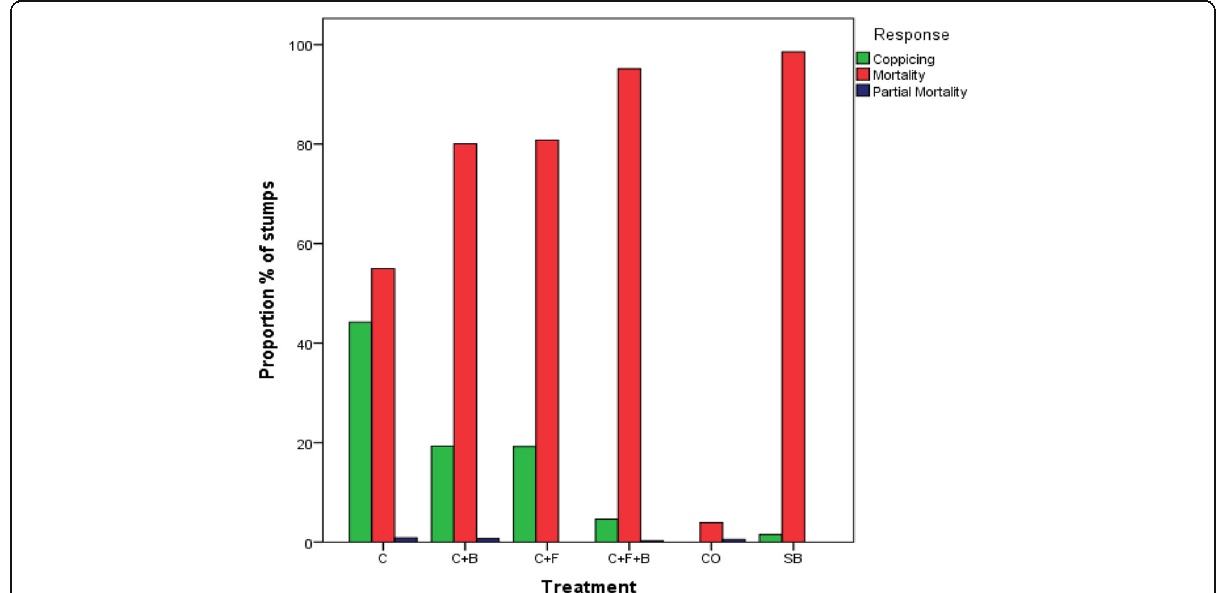
Fig. 5 Mean proportions (%) of coppicing and mortalities among six bush control